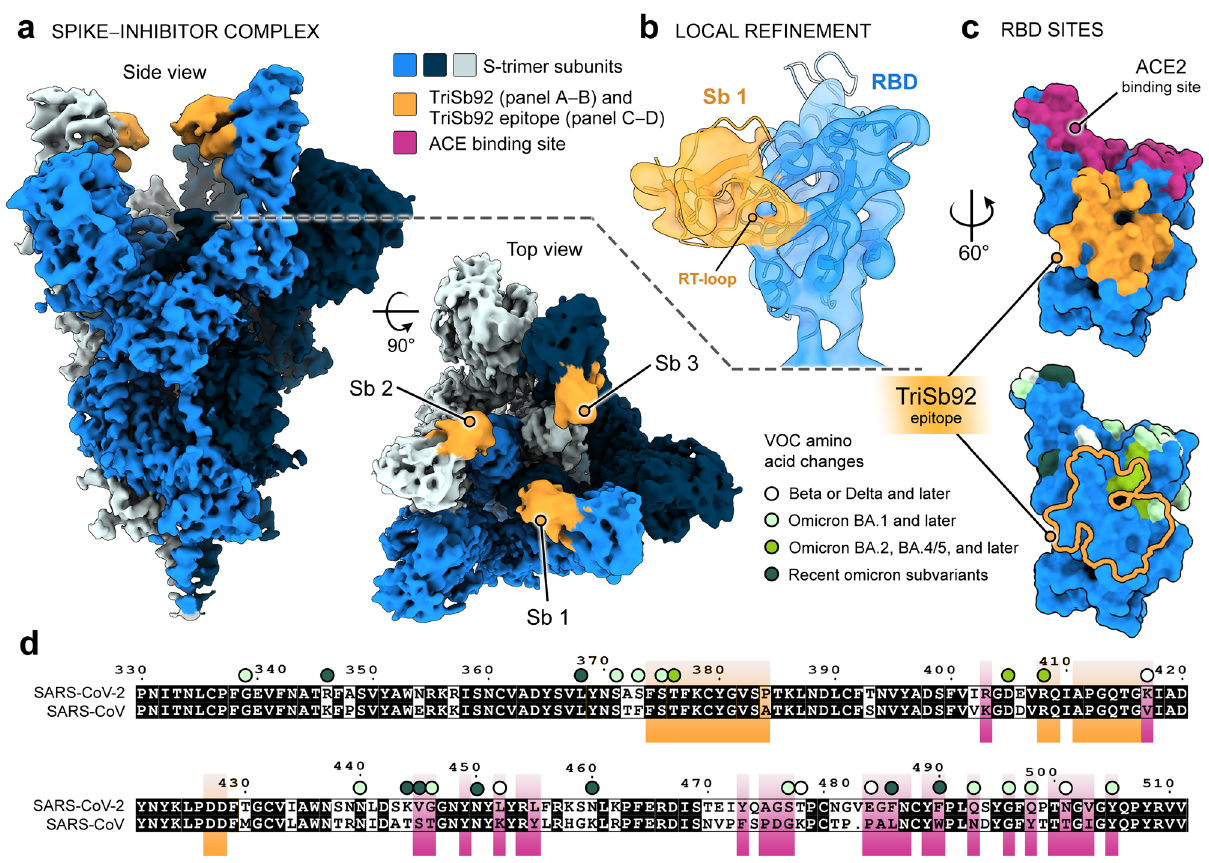
Fig. 6 | Cryo-EM of SARS-CoV-2 S in complex with TriSb92 reveals the highly conserved TriSb92 binding site. a Side and top views of the cryoEM reconstruc- tion of spike trimer in complex with TriSb92. b Locally re fi ned cryoEM recon- struction of the RBD region, with fi tted models of Sb92 (generated with I-TASSER) and the RBD (PDB 7KMS; https://www.ncbi.nlm.nih.gov/Structure/pdb/7KMS). c Surface rendering of the RBDwiththeACE2binding site and the TriSb92epitope highlighted (upper panel), and the locationofaminoacid changesinVOCs relative totheTriSb92epitopehighlighted(lowerpanel). d